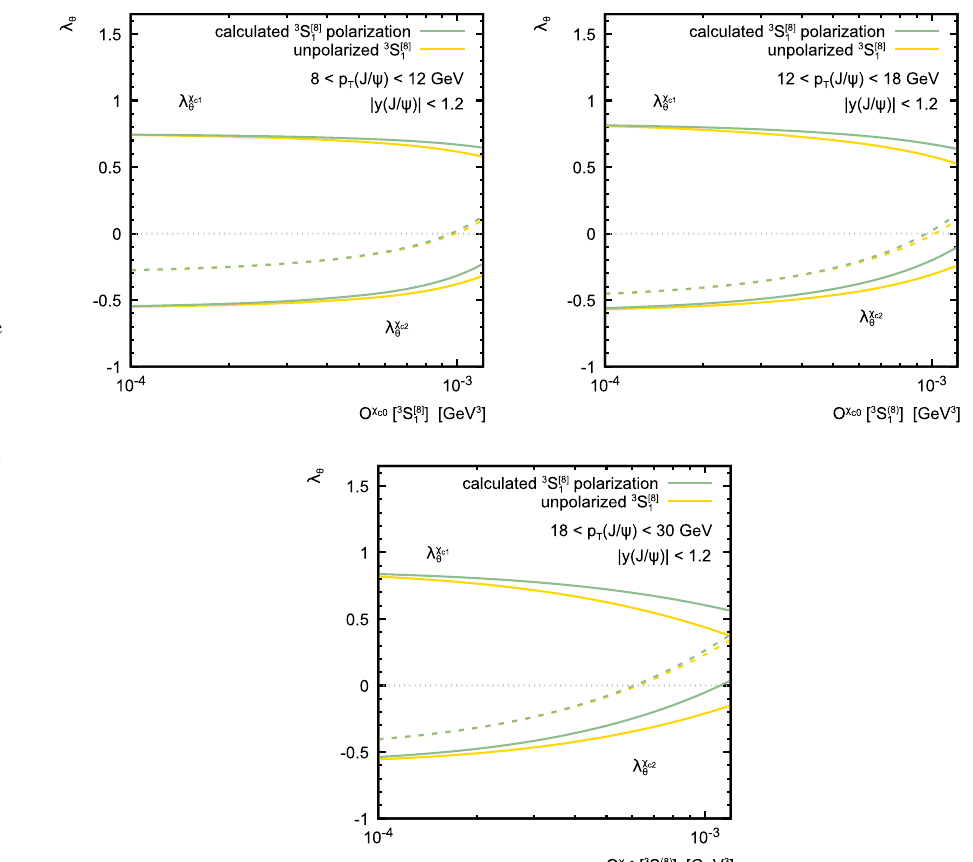
Fig. 1 Polarization parameters λ χ c 1 λ χ c 2 θ and θ calculated as a (cid:9) (cid:10) 3 S [ 8 ] in the functions of O χ c 0 1 helicity frame at | y ( J /ψ) | < 1 . 2 and √ s = 8 TeV in three different p T regions. Solid green and yellow curves represent the results of exact and approximated (when the intermediate 3 S [ 8 ] state is taken 1 unpolarized) calculations. Dashed curves correspond to the correlations (5)–(7) reported by the CMS Collaboration [1]. Everywhere, the JH’2013 set 2 gluon density is used. The color-octet LDMEs are assumed to obey HQSS (“fit I”